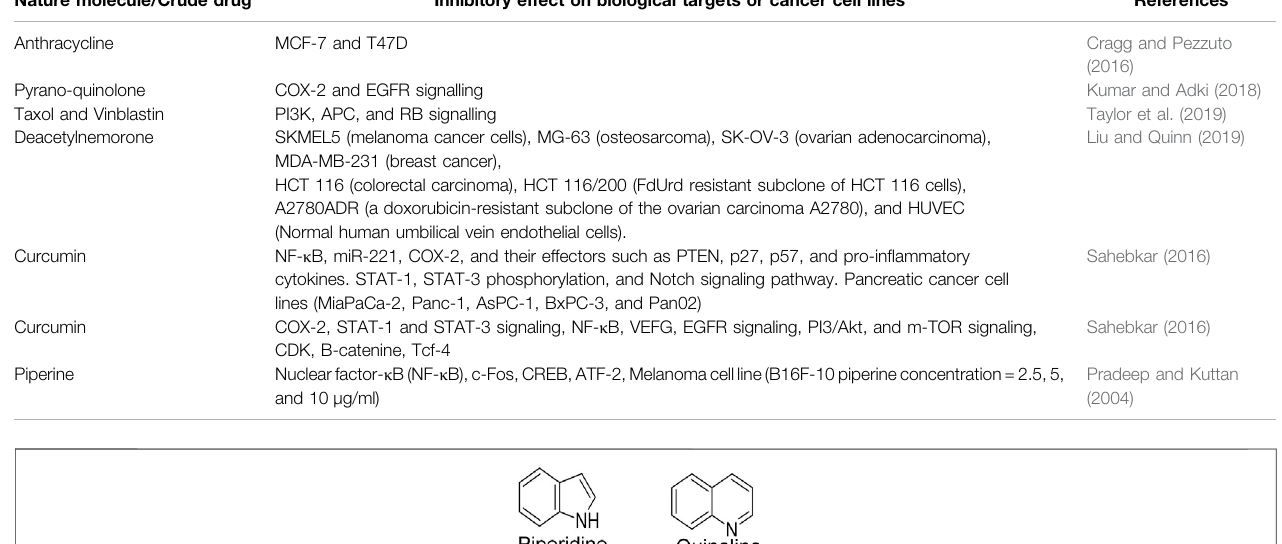
TABLE 3 | Multitarget-based anti-cancer natural compounds. Nature molecule/Crude drug